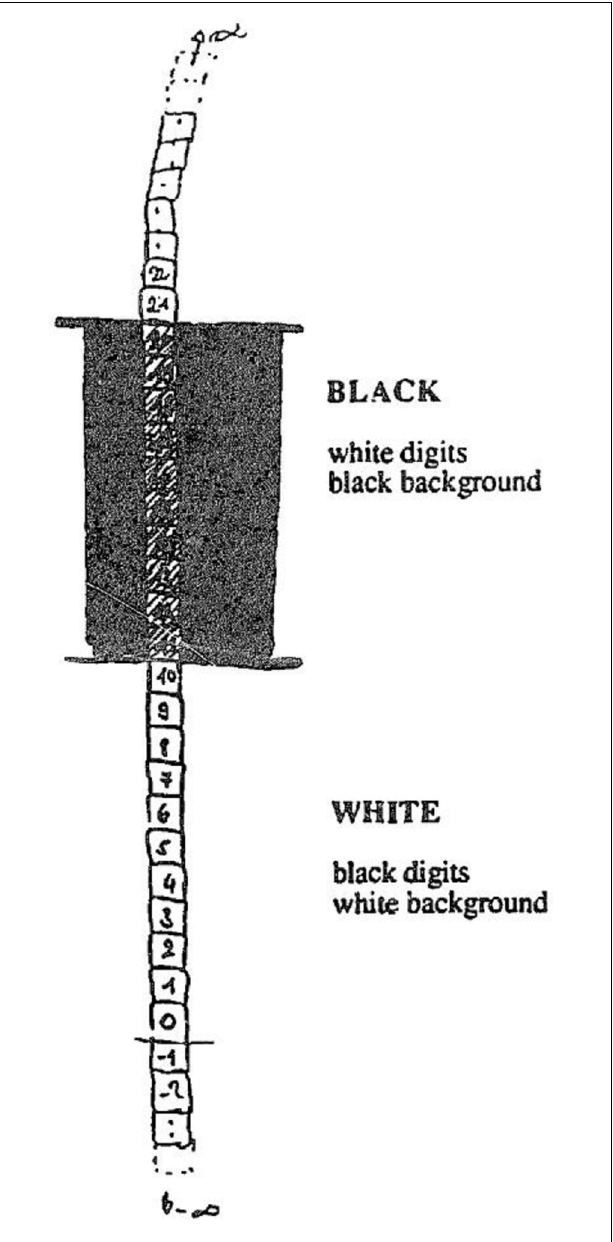
FIGURE 2 | Number form for subject JB reported in Seron et al. (1992). Note the features of defined background color, similar to the context reported by our subject, and the high contrast between digit and background color, which we propose to be a feature of the context, enabling the concurrent to be readily visible. Reproduced with permission from Seron et al. (1992), with permission from Elsevier Limited. License Number: